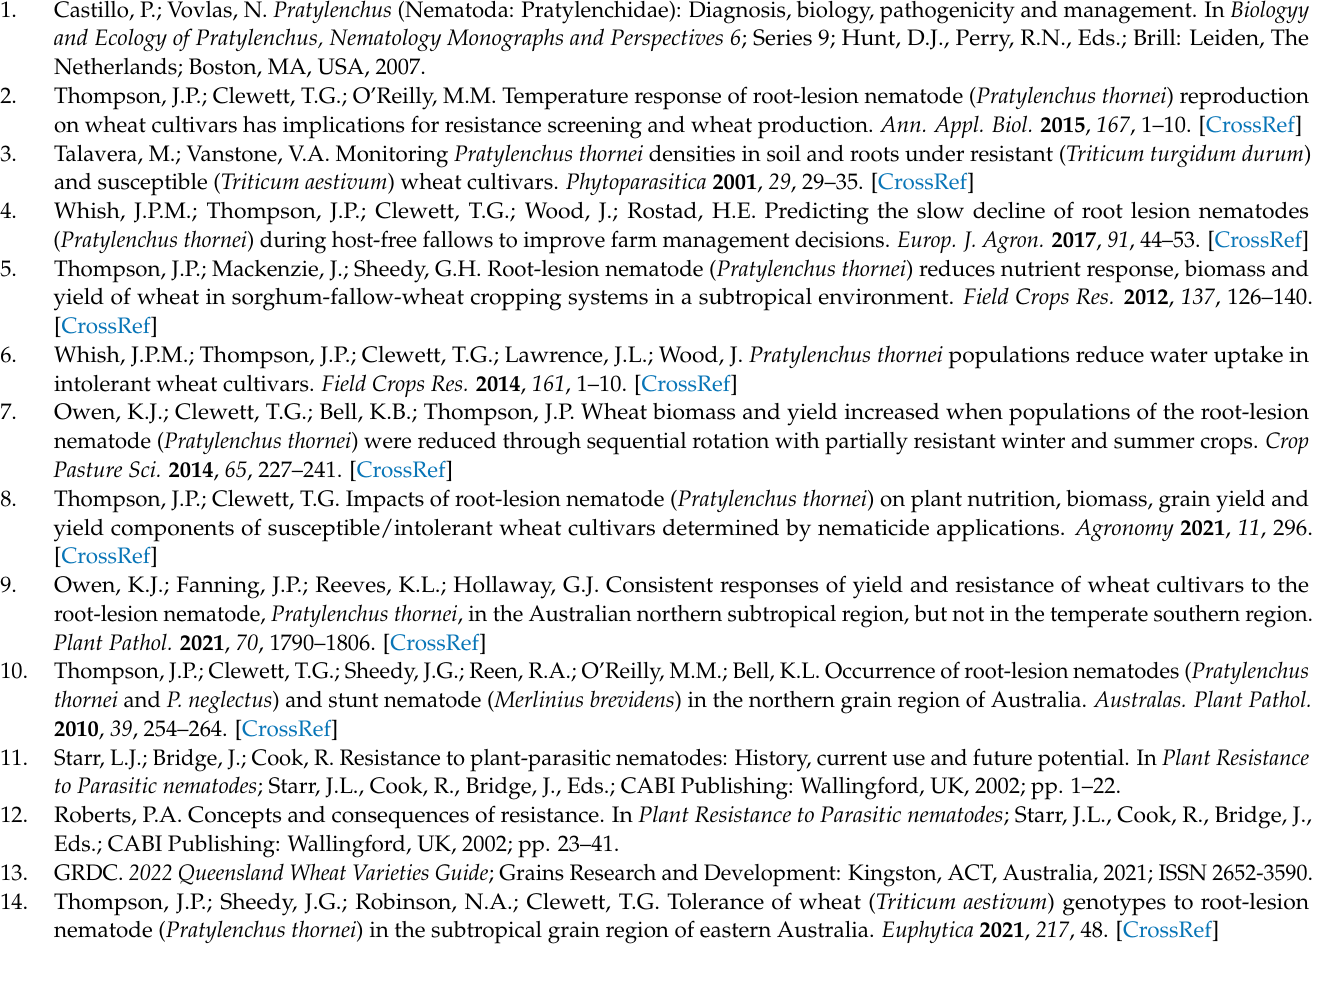
for each Phase 1 treatment. Figure S1: Merlinius brevidens /kg soil at 0–0.9 m soil depth, 6 months after harvest of the Phase 1 treatments (2 months prior to sowing the Phase 2 wheat cultivars). Bar marker above barley, chickpea and faba bean indicates l.s.d. ( p = 0.05) experimental site x crop; BTM, back-transformed means; error bar indicates standard error of the mean; n = 36 for barley, chickpea, and faba bean; n = 30 for wheat; n = 6 for